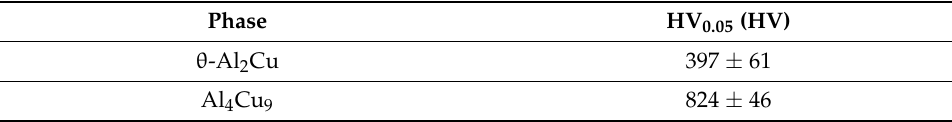
Table 3. Vickers hardness of θ -Al 2 Cu and Al 4 Cu 9 IMCs.